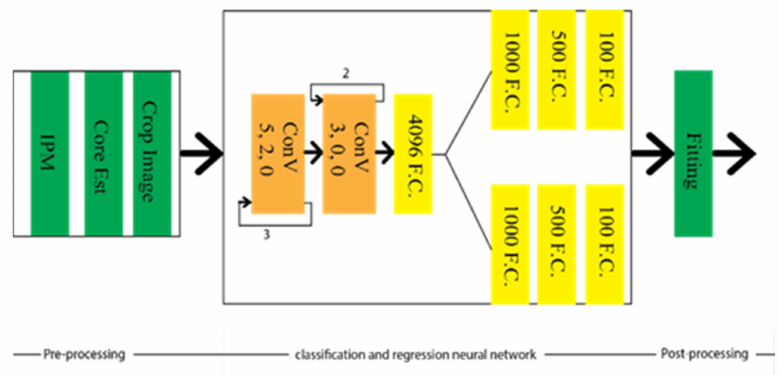
Figure 4. Schematic diagram of spatial and temporal based LMD technique.